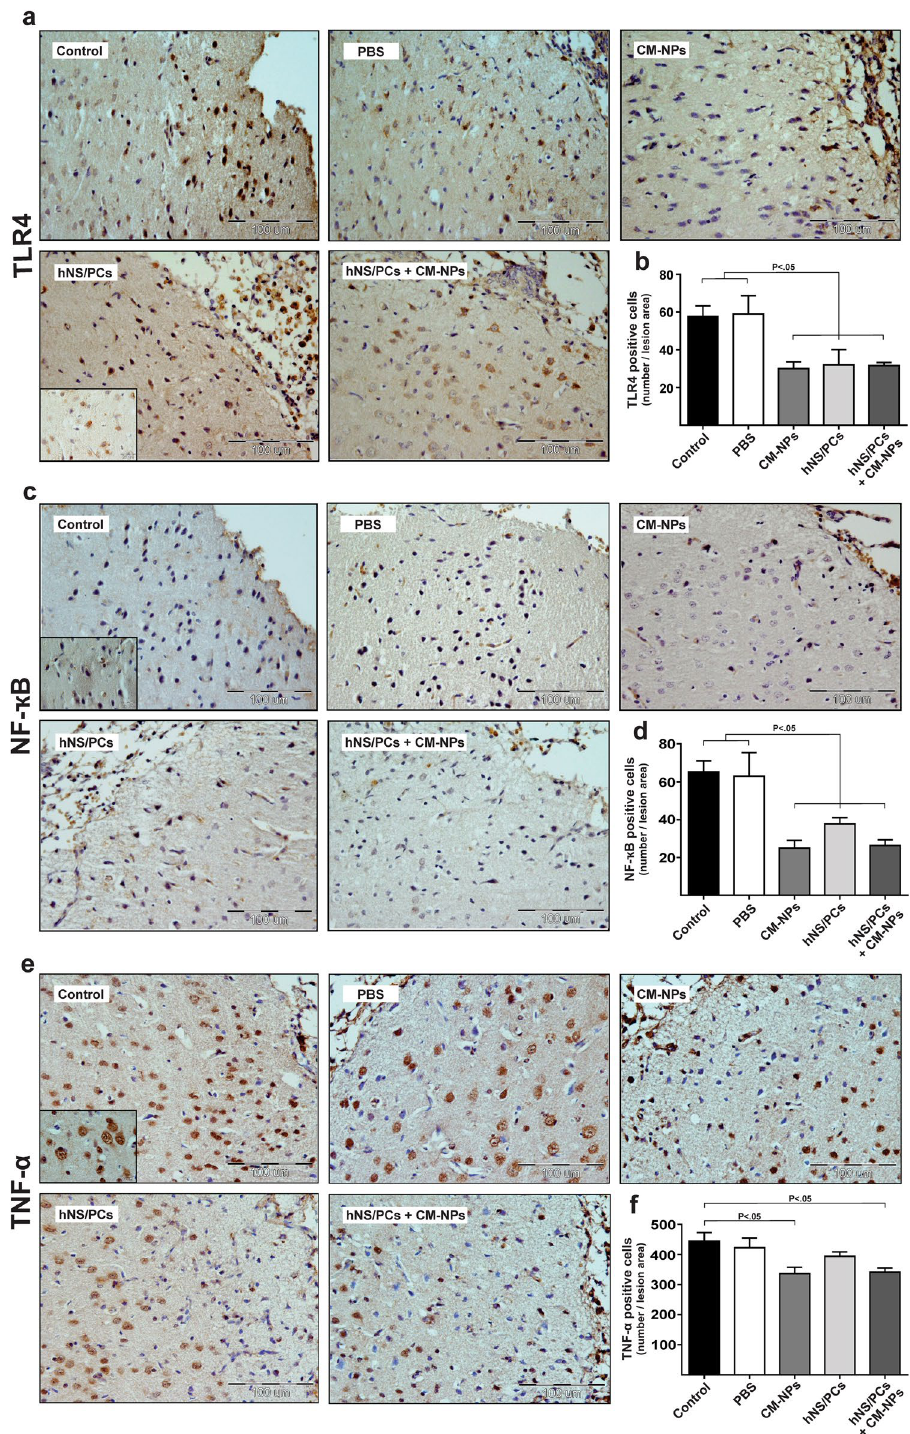
Figure 7. Immunohistochemistry staining of TLR4-, NF-κB-, and TNF-α-positive cells at the injury site after TBI and cell transplantation in experimental groups. ( a ) Representative images of TLR4-positive cells (i.e., brown stain) within the injury site on day 28 after induction of TBI. ( b ) The mean number of TLR4-positive cells significantly decreased in the CM-NPs, hNS/PCs, and hNS/PCS + CM-NPs groups compared to the control and PBS groups. ( c ) Representative images of immunohistochemistry slides of NF-κB-positive cells as shown brown stain. ( d ) Bar graphs show the mean number of NF-κB- positive cells in the lesion area after 28 days of TBI in different experimental groups. The bar graphs indicate a significantly lower expression of NF-κB-positive cells in the CM-NPs, hNS/PCs, and hNS/PCS + CM-NPs groups compared to the control and PBS groups. ( e ) TNF-α-positive cells indicated brown stains are shown within the injury site after 28 days of TBI. ( f ) The mean number of TNF-α-positive cells significantly decreased in the CM-NPs and hNS/PCS + CM-NPs groups compared to the control group. Data are presented as the mean ± SEM (n =